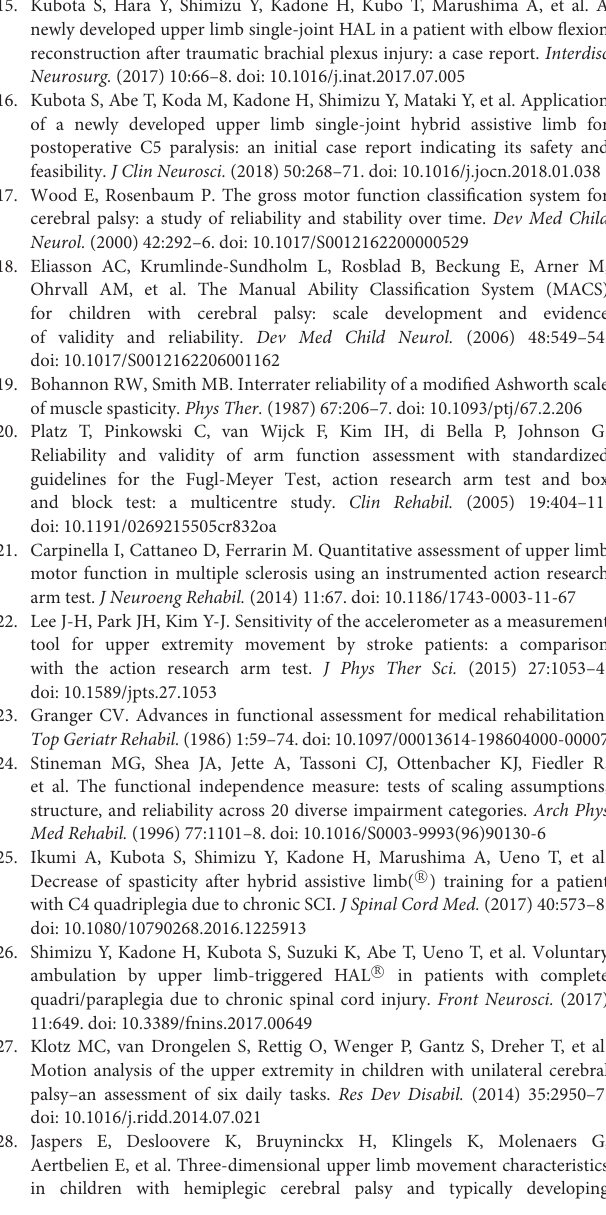
Supplementary Table 2 | Change in dynamic voluntary elbow extension and flexion angle in Left-sided HAL in Case 1 and Right-sided HAL in Case 2. Supplementary Video 1 | This movie shows the voluntary elbow extension-flexion for the right arm before, during, and after the first HAL session for the right elbow in Case